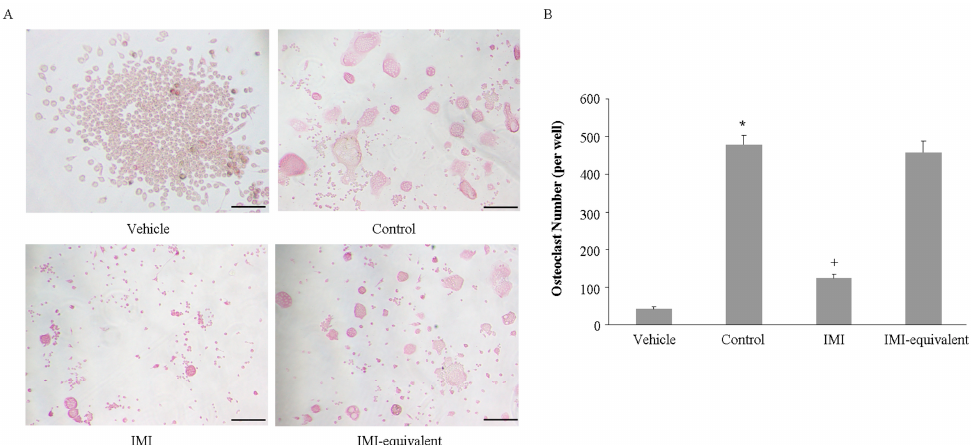
Figure 5. Imipramine affects MV-induced osteoclast formation. ( A ) RAW264.7 cells and MVs shed from PTH-treated UAMS-32P cells with or without imipramine treatment were co-cultured. Cells were fixed and stained for TRAP; ( B ) The numbers of TRAP staining positive cells. Each bar represents the mean±standard deviation in a 24-wellplate ( n = 3). * p < 0.05 versus vehicle group; + p < 0.05 versus control group. Vehicle: RAW264.7 cells cultured without MVs; Control: co-culture with MVs shed from PTH-treated osteoblasts without imipramine treatment; IMI: co-culture with MVs shed from PTH-treated osteoblasts with imipramine treatment; IMI-equivalent: co-culture withthe same amount of MVs from the IMI group as the control group. Bar, 100 µm.